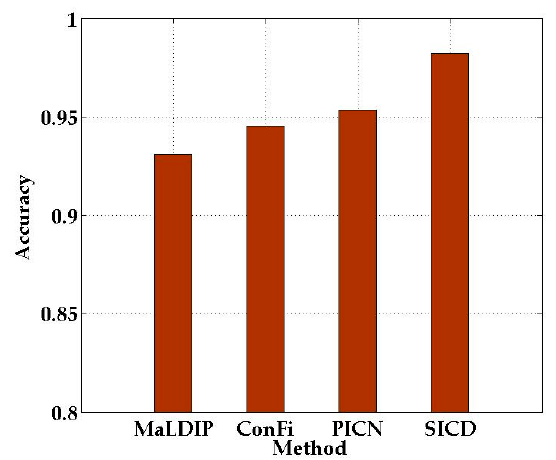
Figure 13. Average localization accuracy of the different methods.